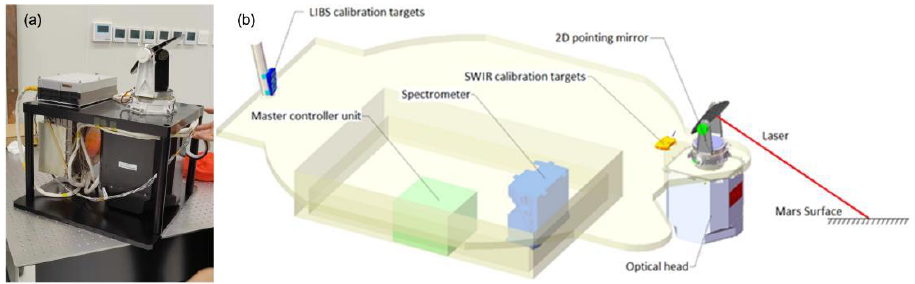
Figure 1. ( a ) Appearance of the MarSCoDe laboratory model. ( b ) Schematic diagram of the MarSCoDe instrument suite onboard the Zhurong rover. Table 1. Main t echnical specifications of the MarSCoDe instrument.